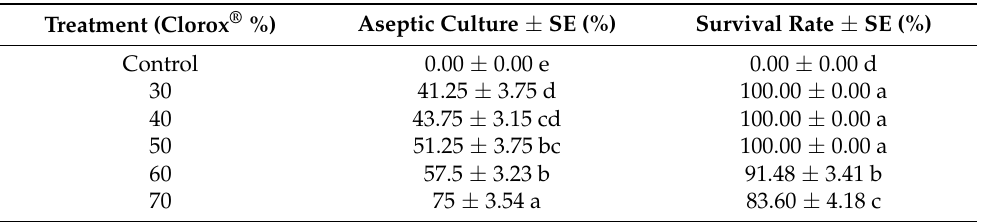
Table 1. Effects of different Clorox concentrations for 30 min immersion on explant surface steriliza- tion and survival rate of ‘Bentong’ ginger rhizome sprouted buds explants. Treatment (Clorox ®